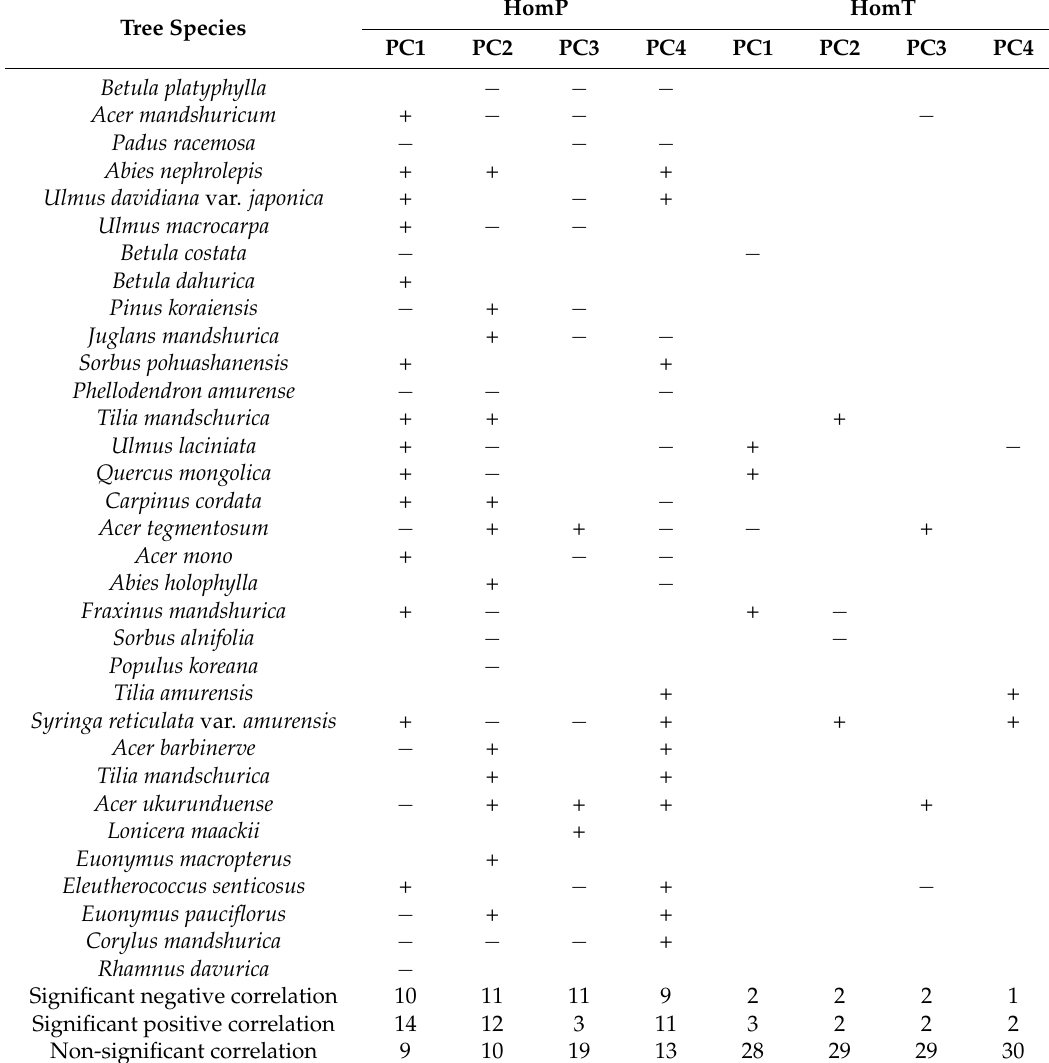
Table 3. Relationships between species distribution and one of the first four PC axes of soil nutrients in the upper soil layer. HomP represents the homogeneous Poisson process; HomT represents the homogeneous Thomas